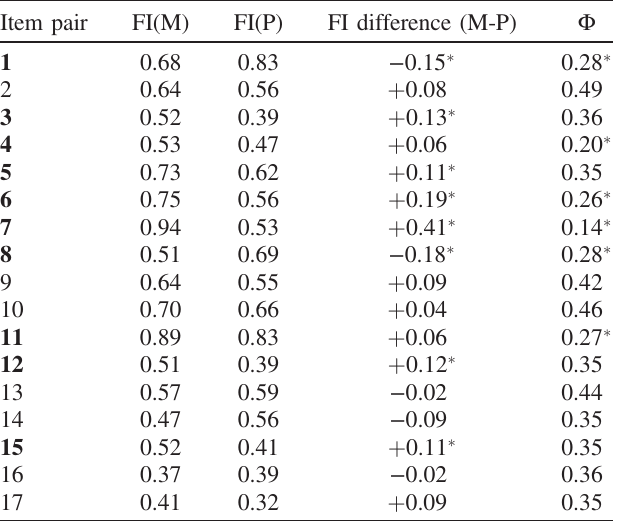
TABLE V. Facility index (FI) differences and phi coefficients ( Φ ) for pairs of parallel items in the context of mathematics (M) and in the context of physics (P). FI differences larger than 10% and Φ values smaller than 0.30 are labeled with an asterisk, and the item pairs having at least one of the two values above threshold are marked in